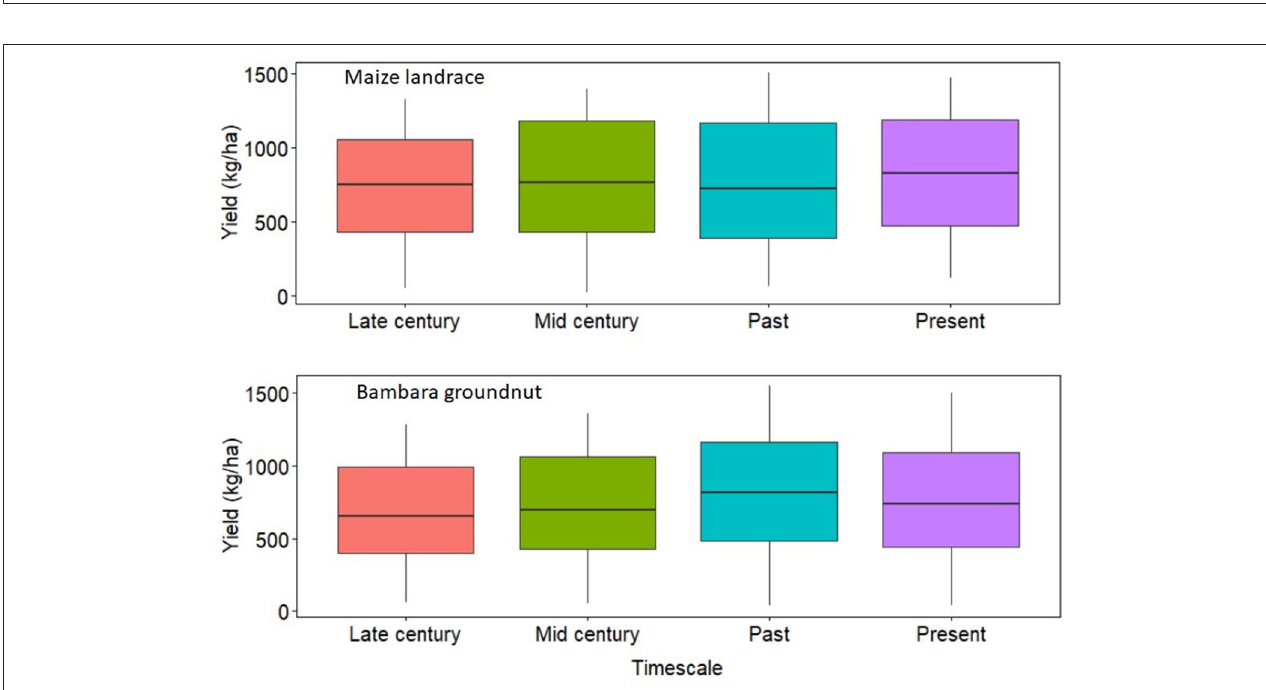
FIGURE 7 | Simulated maize landrace and bambara groundnut yields (kg ha − 1 ) across different timescales from six GCM (ACC, CSS, CNR, GFD, NOR, and MPI). The effect of timescale on bambara groundnut yield F -statistic: 5.031 on 3 DF, P = 0.001.